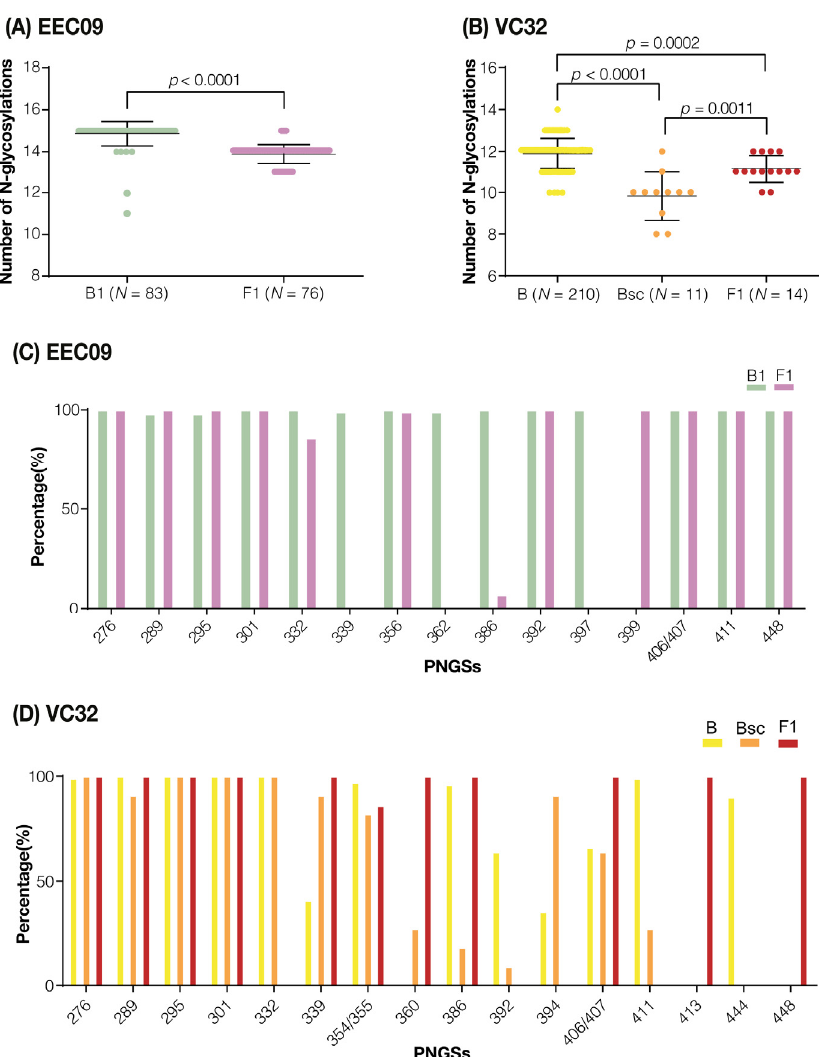
Figure 5. Analyses of N-linked glycosylation in the env gp120 C2-C4 region of viral sequences from subjects EEC09 and VC32. ( A , B ) Dot plots with the numbers of estimated PNGSs in env sequences from subtype B and F1 populations. Horizontal lines represent the mean and standard deviation.